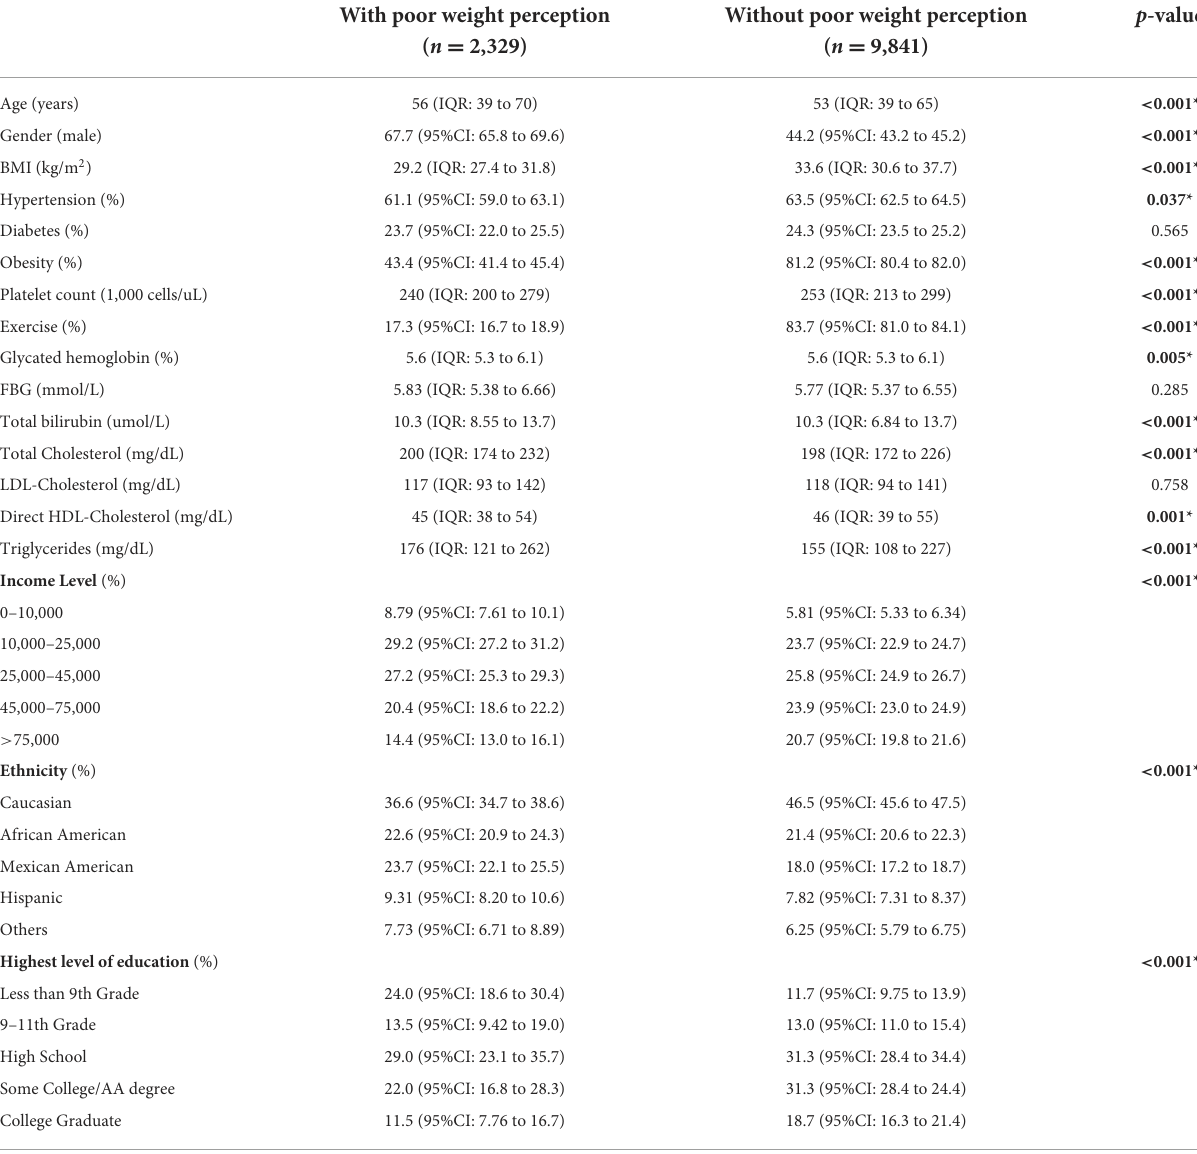
TABLE 1 Baseline demographics of NAFLD individuals with and without poor weight perception.